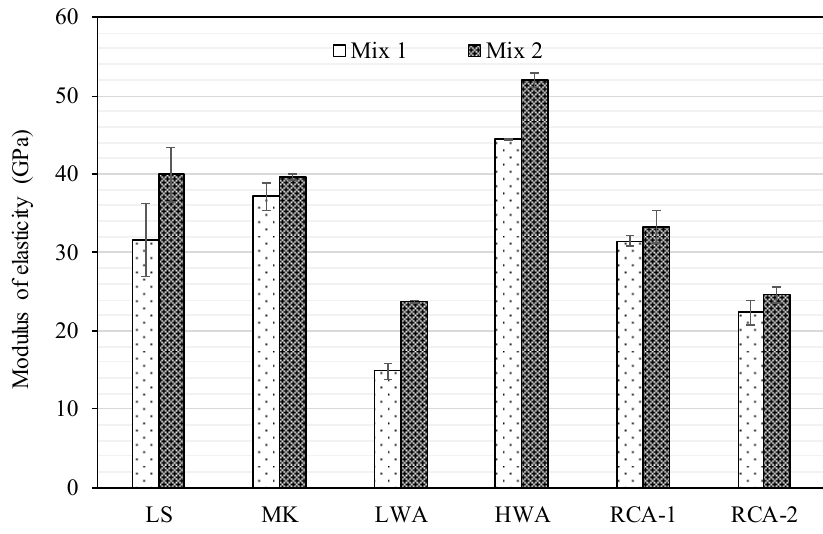
Figure 8. Modulus of elasticity results for Mix 1 and Mix 2.